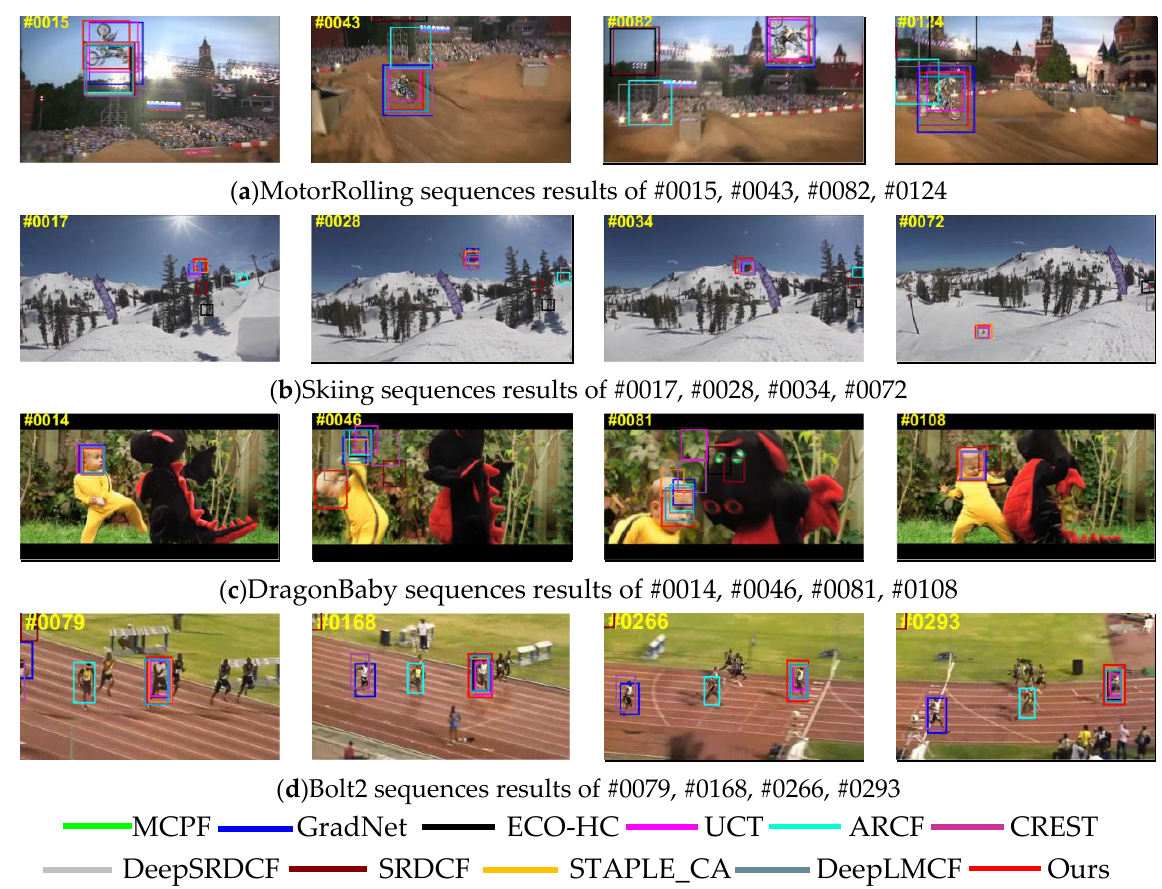
Figure 5. Qualitative evaluation of the proposed tracker with comparison to 10 trackers on 5 challenge sequences (from left to right and top to down are Matrix, MotorRolling, Skiing, DragonBaby and Bolt2).